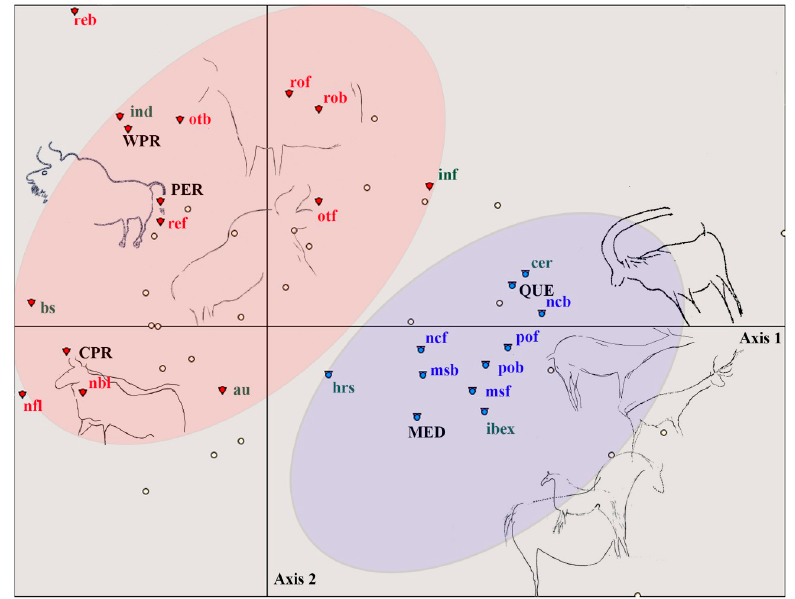
Fig 17. FCA multivariate plot of the studied corpus of 26x26 criteria in the main factorial plane [1,2]. The two- coloured groups are generated by ascending hierarchical clustering (MED: Mediterranean, QUE: Quercy, PER: Perigord, CPR: Central Pyrenees, WPR: Western Pyrenees).